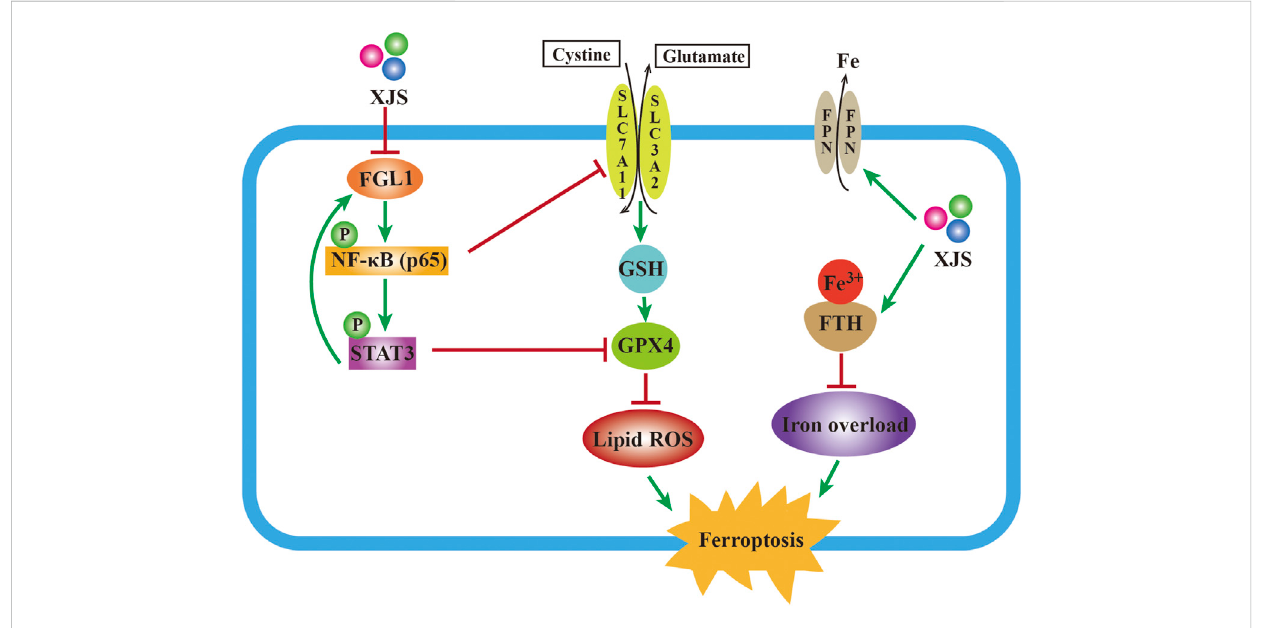
FIGURE 8 Mechanism schematic of XJS alleviating colitis by inhibition of